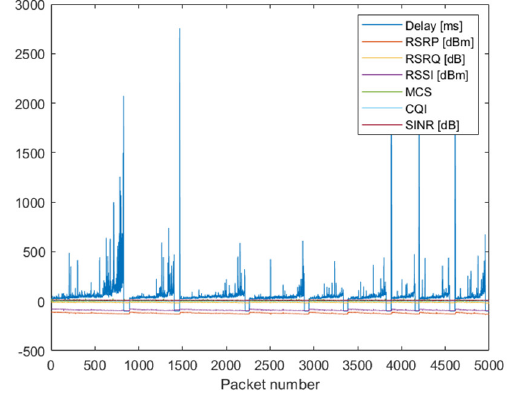
Figure 10. Measurements results of RSRP, RSRQ, RSSI, SINR, MCS, CQI and transmission delay for LTE technology.